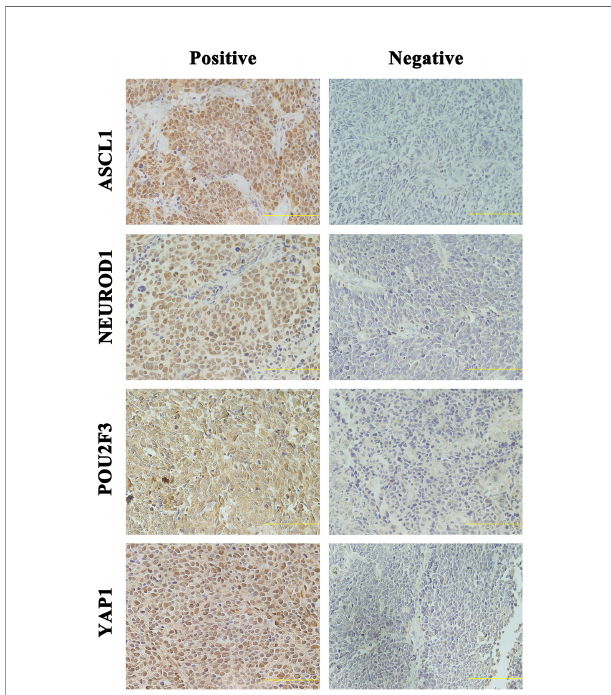
FIGURE 2 | Representative Images of Immunohistochemical Staining in Primary Small Cell Lung Cancer Tumors Positive for One Single Molecular Subtype Marker. Scale bar: 100 m M. Only the tumors with appreciable nuclear staining were considered positive for subtype markers. ASCL1,